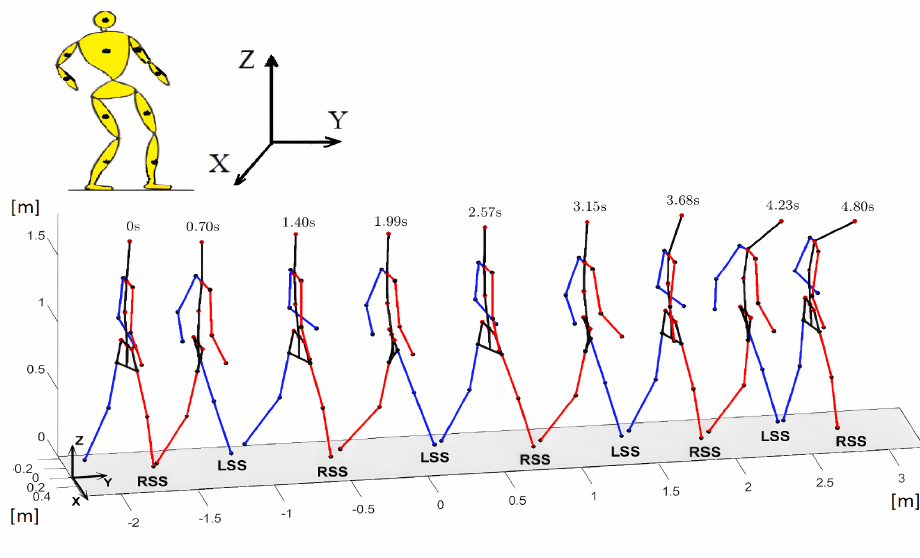
Figure 2. Illustration of considered body segments and example illustration of the sequence of stick diagrams during the walk. RSS denotes a single support phase of the right leg and LSS—single support phase of the left